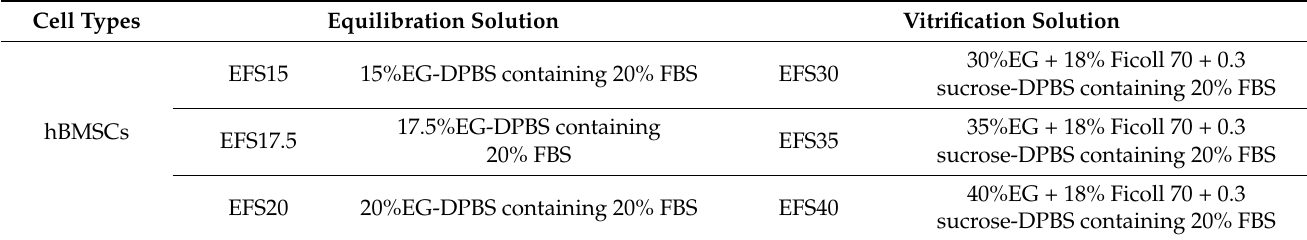
Table 1. Solutions for vitrification of hBMSCs and